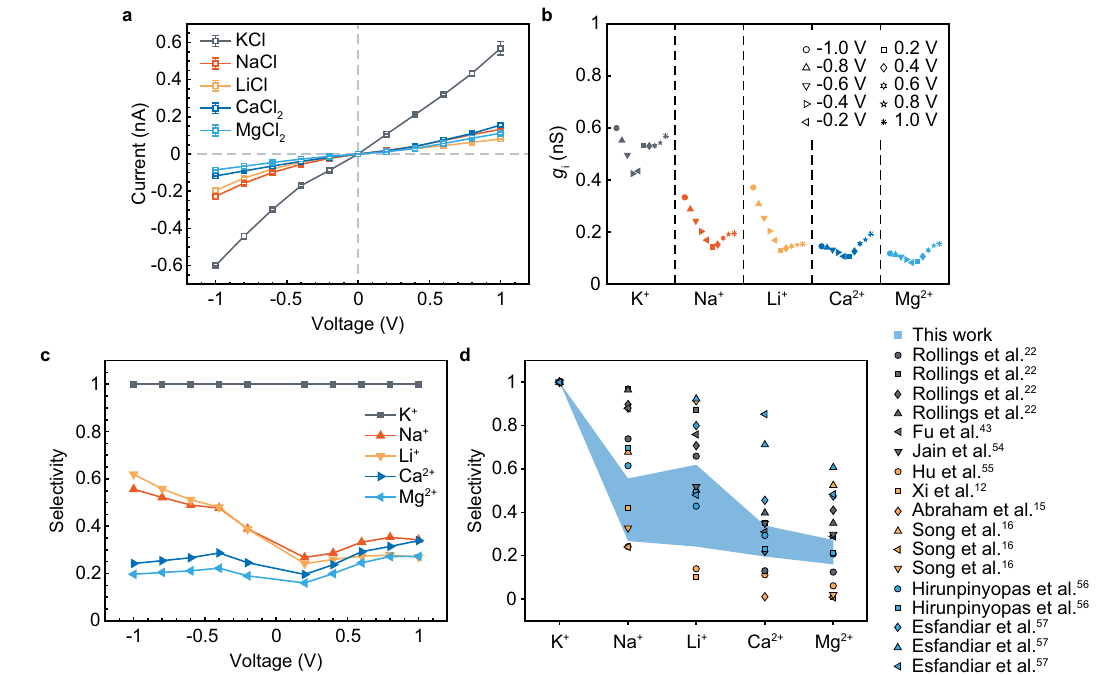
Fig. 2 | Tunable ion selectivity of graphene-based polyethylene terephthalate nanochannel (GPETNC). a I – V curves of the GPETNC in different chloride salt solutions with concentrations of 0.1 M. Error bars were the standard deviations from the average of three independent records. b Normalized conductance g i of cation i for the GPETNC at different voltages. c Ion selectivity of the GPETNC at different voltages. d Comparison of ion selectivity of the GPETNC and other nanoporousatomicallythinmembranes(NATMs)inexperiments.Theselectivity of different cations was normalized by that of K + . Based on the type of experi- mental settings, selectivities exhibited here were divided into three groups: